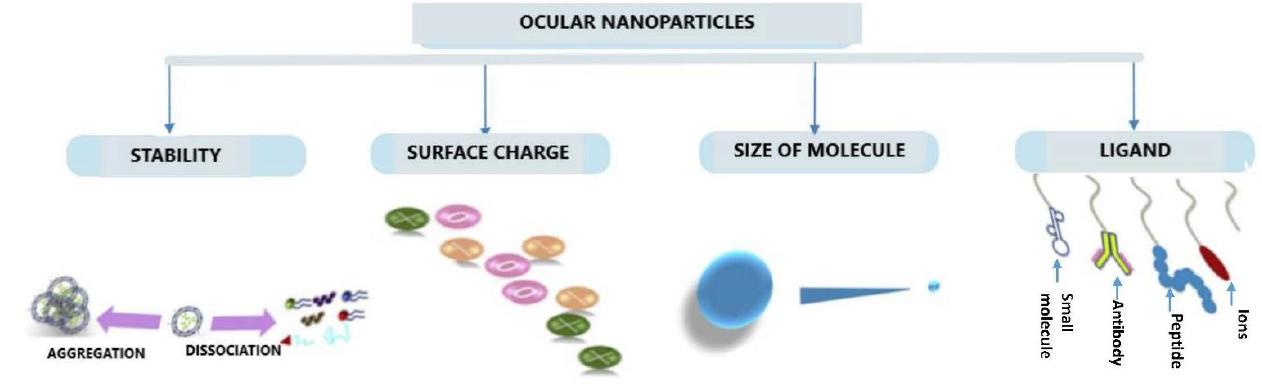
Figure 3. Characteristics of the ocular nanoparticles that affect their intraocular distribution and elimi- nation.